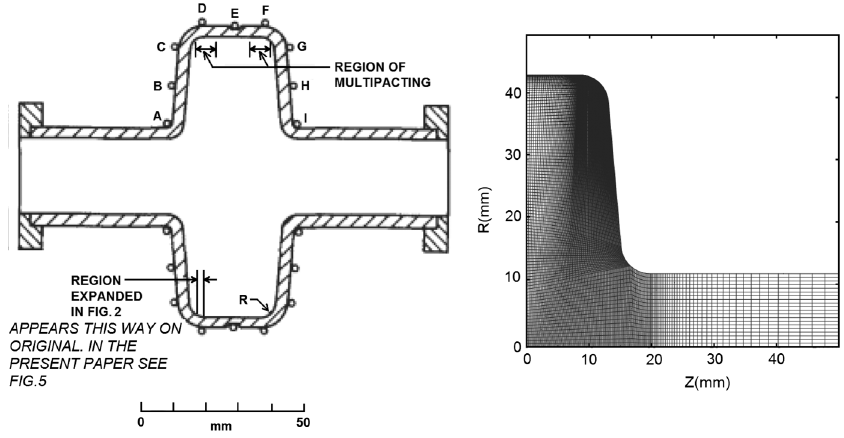
FIG. 1. Schematic drawing of the S-band cavity from [1] and geometry with mesh for SLANS